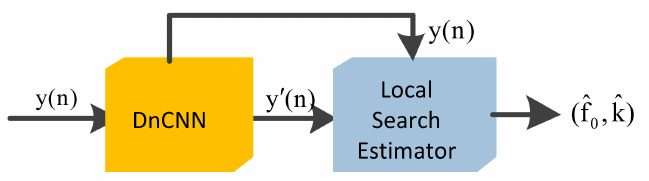
(cid:16) (cid:17) is the output of the proposed (cid:98) f 0 , ˆk